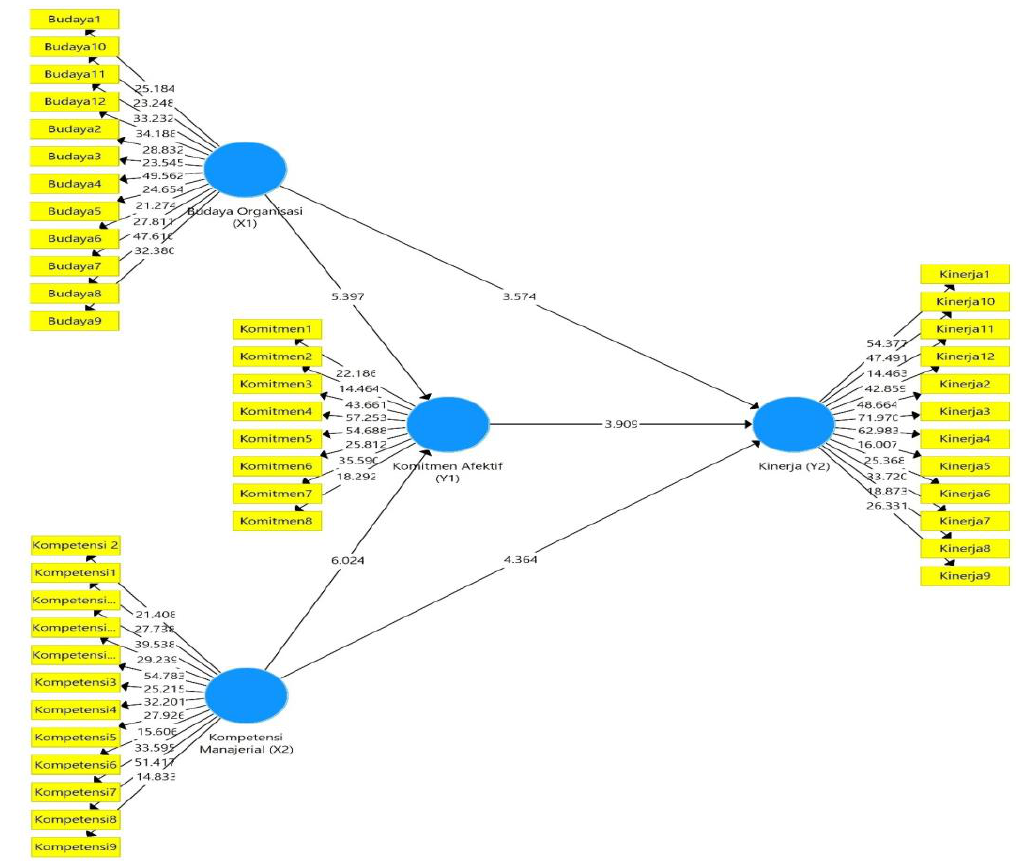
Figure 2: Bootstrapping Output; Source: SmartPLS 3.3.3 Output,